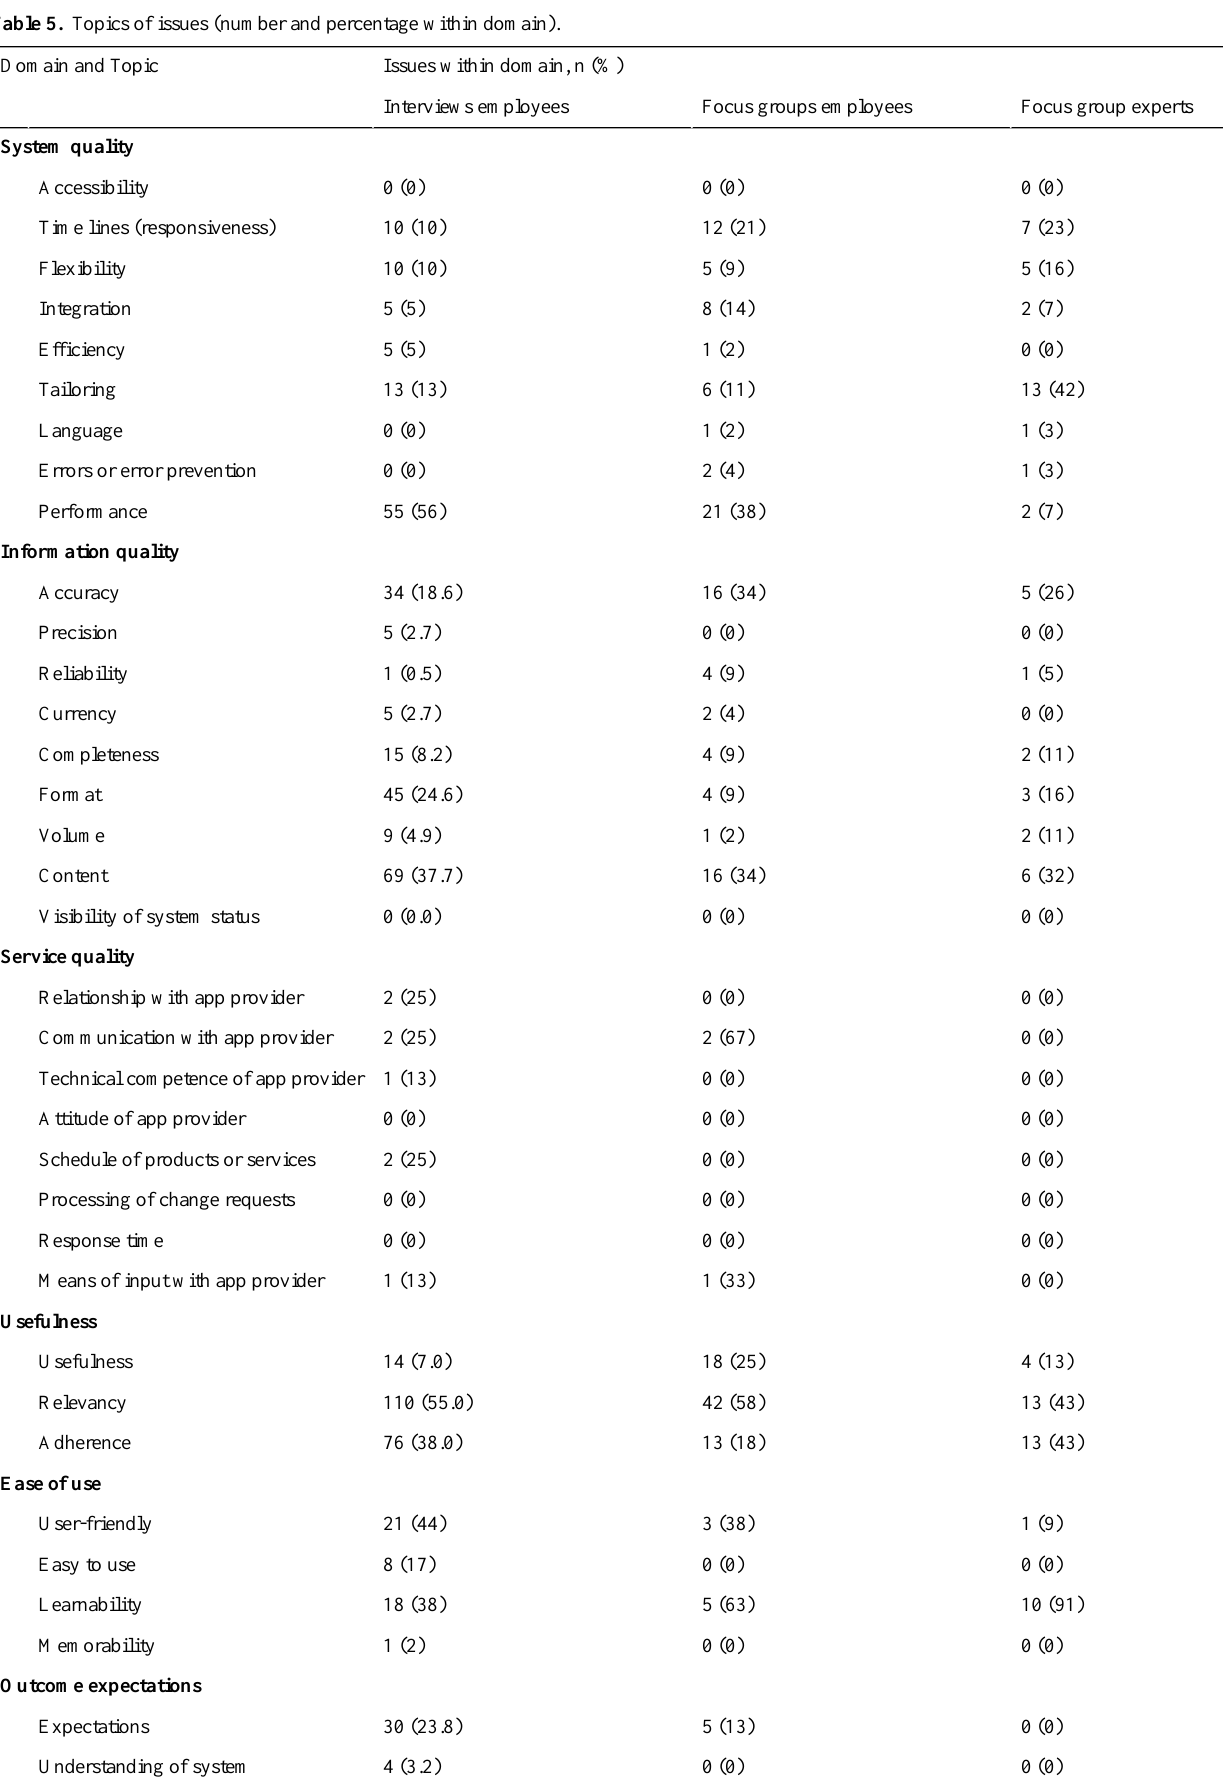
Table 5. Topics of issues (number and percentage within domain).